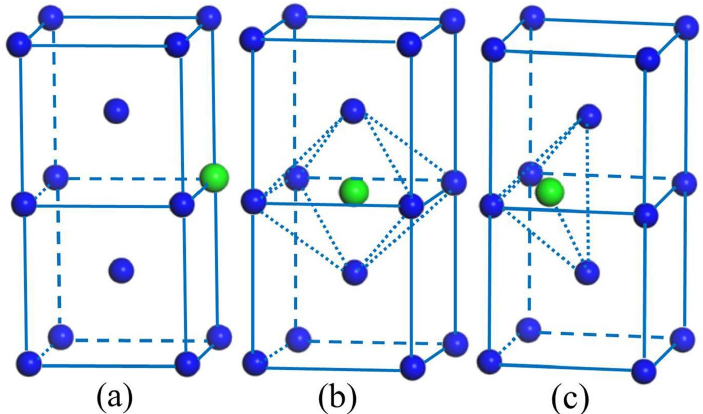
Figure 1. The substitutional site ( a ), the octahedral interstitial site ( b ) and the tetrahedral interstitial site ( c ) in bcc W structure. The large green spheres show the sites of the substitutional and interstitial; the blue spheres are the bcc W lattice sites.